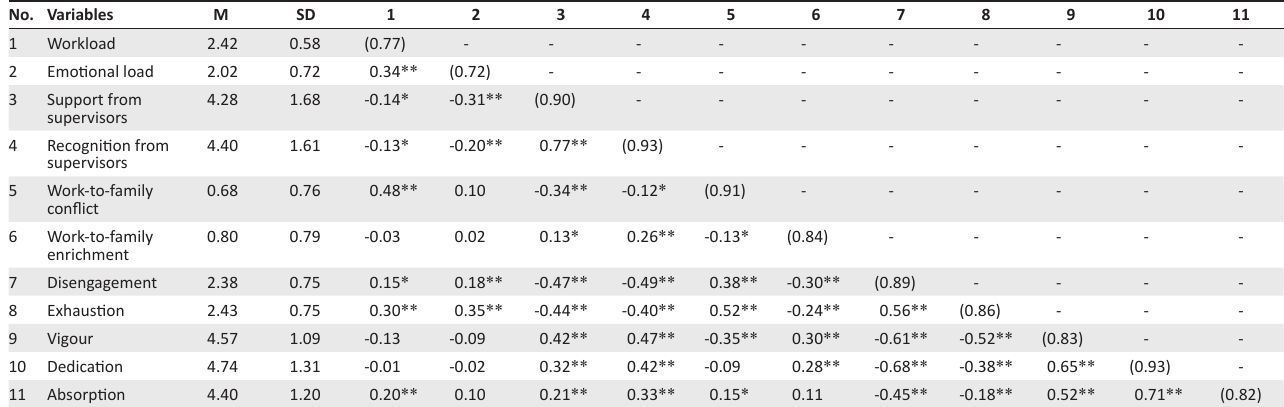
TABLE 2: Descriptive statistics and inter-correlations amongst variables ( N = 226). No. Variables